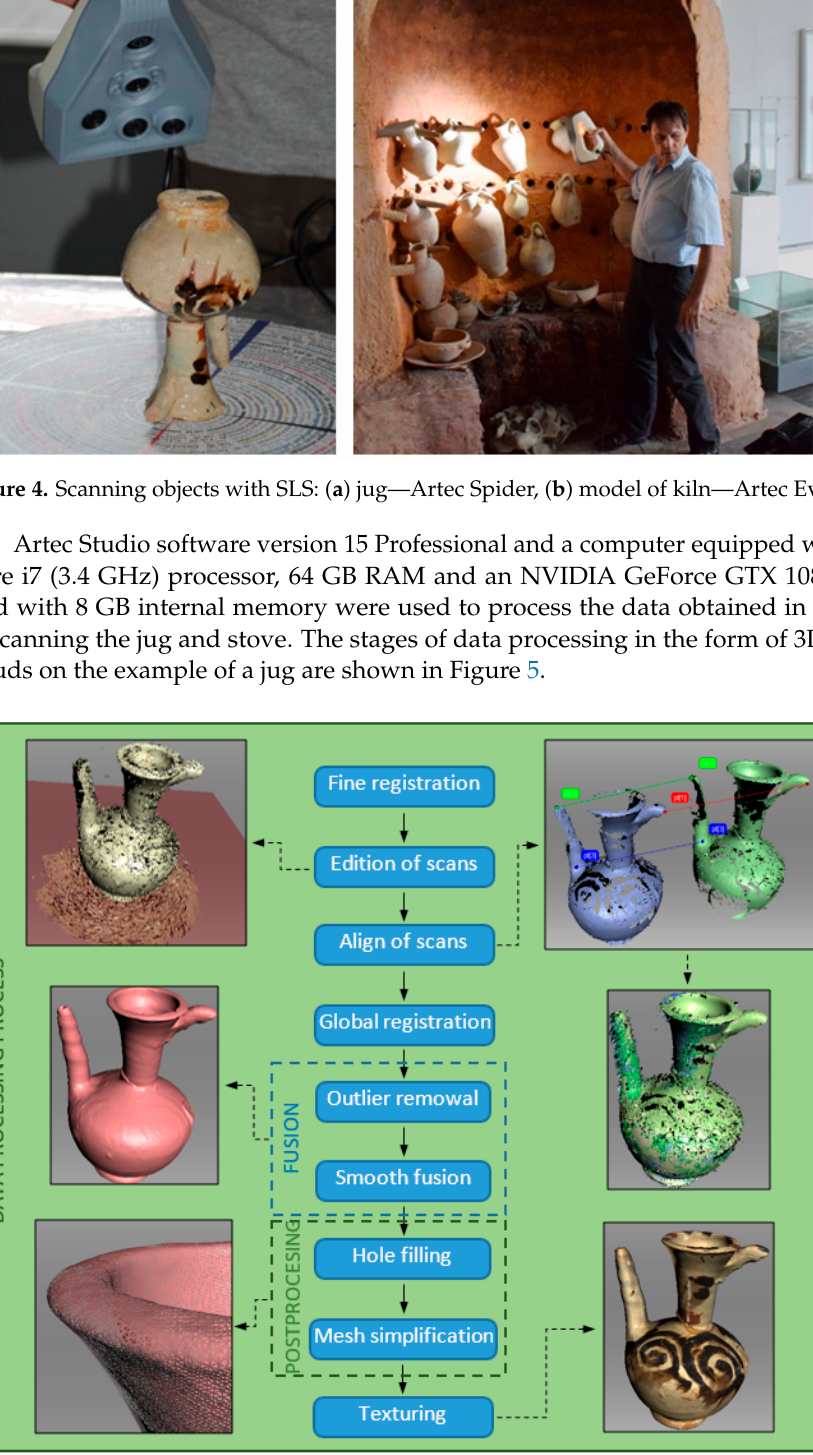
Figure 5. Stages of data processing obtained in the scanning process.